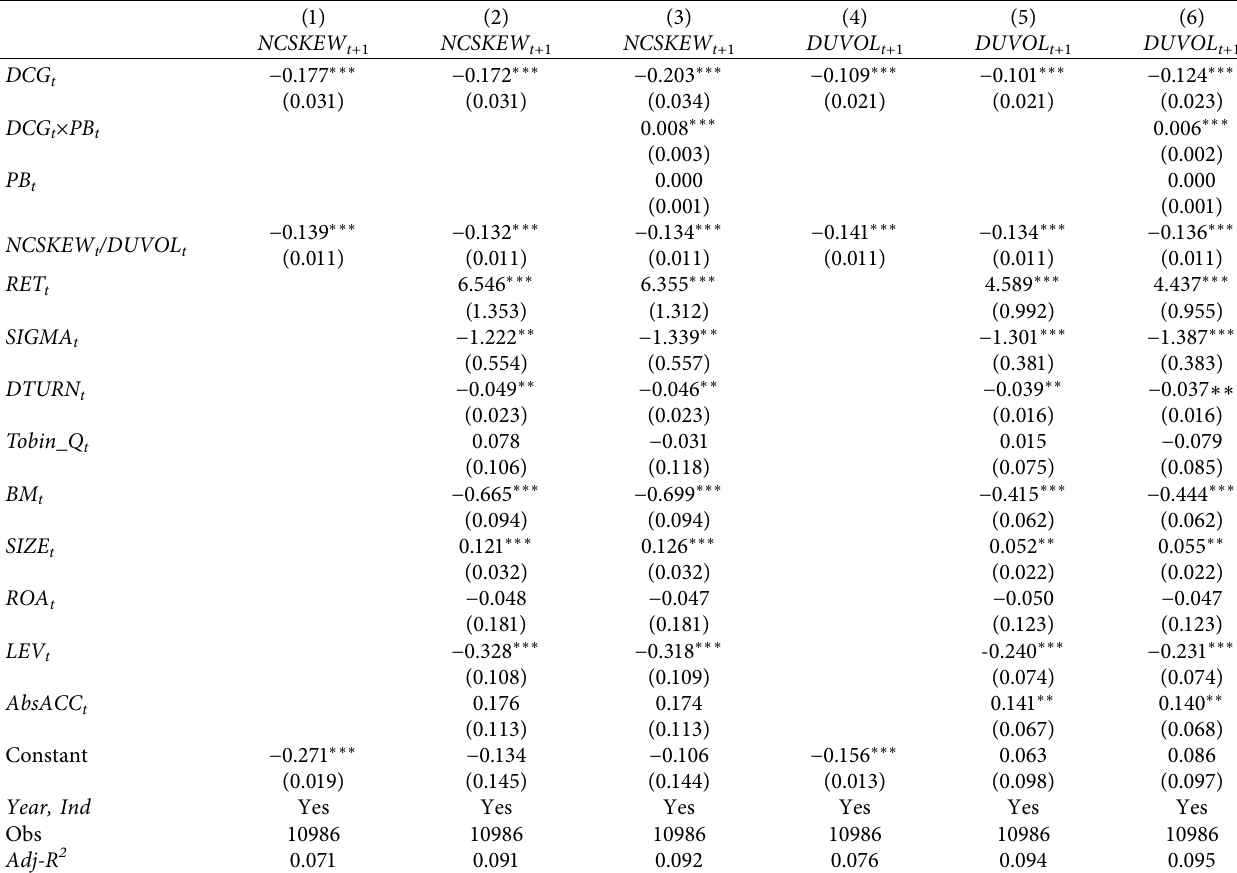
Table 2: EDT and stock price crash risks.